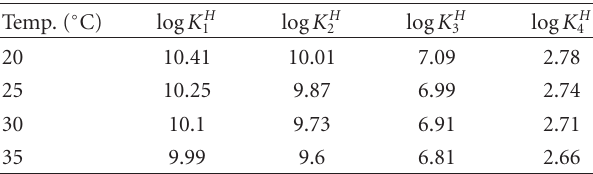
Table 1: Protonation constants of (BAPP) in aqueous solution at di ff erent temperatures (at 0.01 M ionic strength).